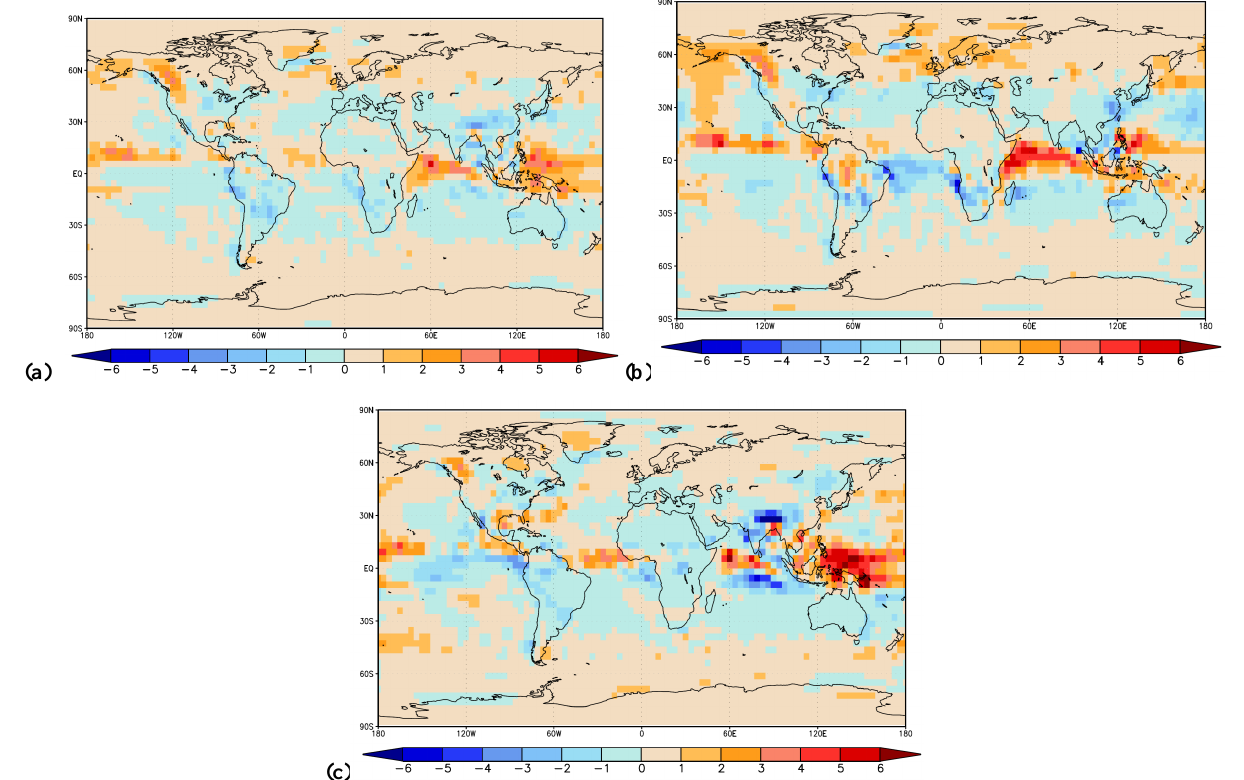
Fig. 11. As Fig. 10, but for experiment